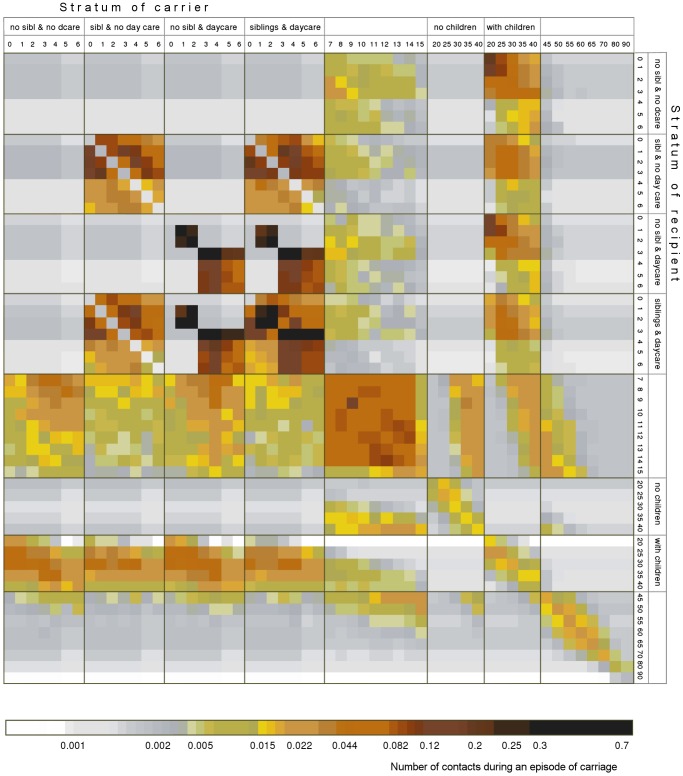
Basic reproduction matrix K.Each column in the plot corresponds to a single carrier of a given stratum. The stratification is based on 29 age groups, presence of siblings under 7 years of age (yes/no for children <7 years of age), parental status (with/without children <7 years of age for adults 20–45 years of age), day care attendance (yes/no). Each entry indicates the average number of infectious contacts from a single carrier in stratum j (column) to a one-year age cohort of individuals in stratum i (row). Darker colours indicate higher numbers. The numbers are calculated from the distribution of social contacts extracted from the simulation and applying the most optimal parameter combintation. The column/row numbering refers to the lower limit of the age group.